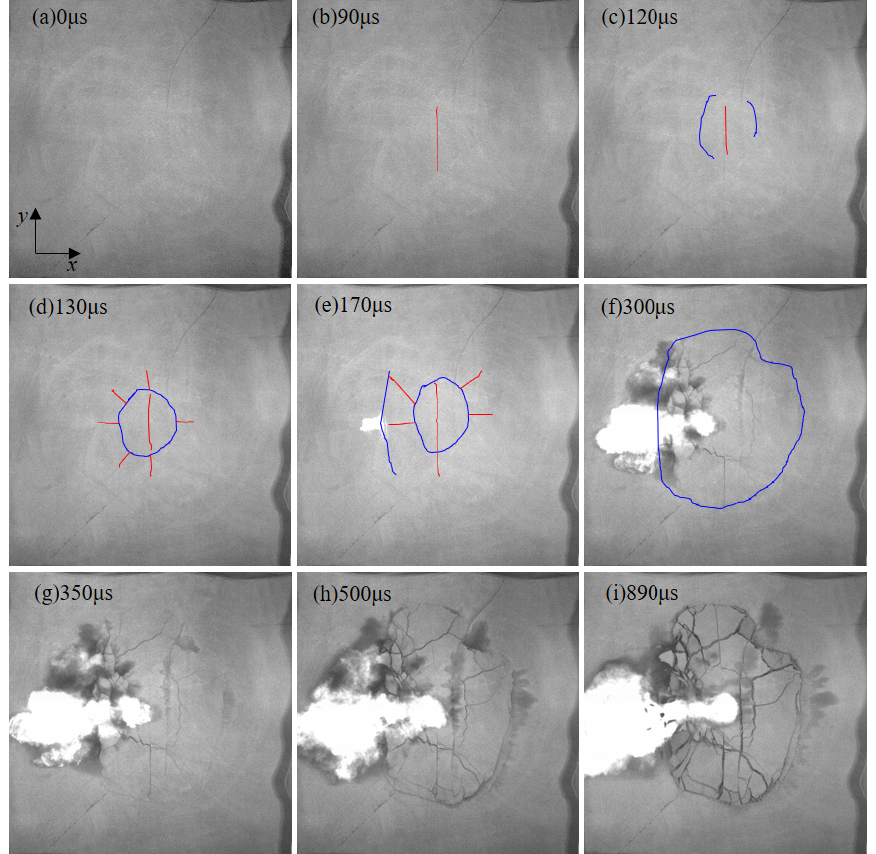
Figure 7. The crack network at different times during crater blasting under an SSR of 0.3. ( a – i ) The crack network after 0, 90, 120, 130, 170, 300, 350, 500, and 890 μs of explosion, respectively.